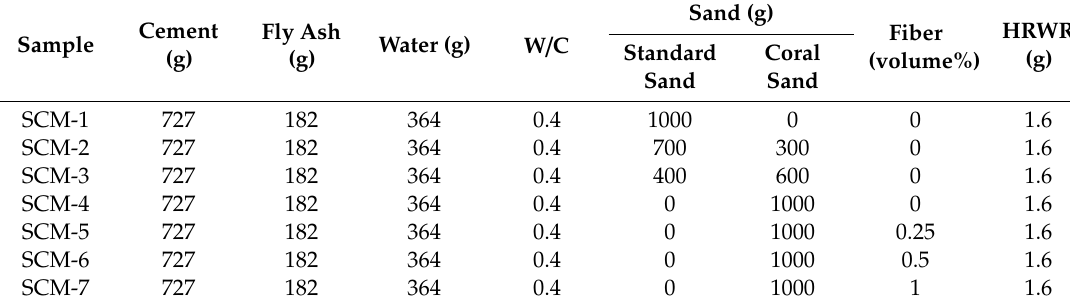
Table 5. Mixture proportions of the mortar used in this